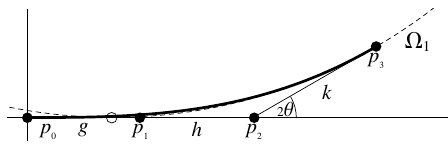
Figure 5. A J-shaped transition curve in normalized